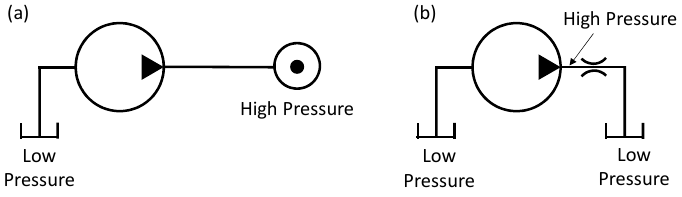
( a ) volume-termination (VT) ( b ) restriction-termination (RT).